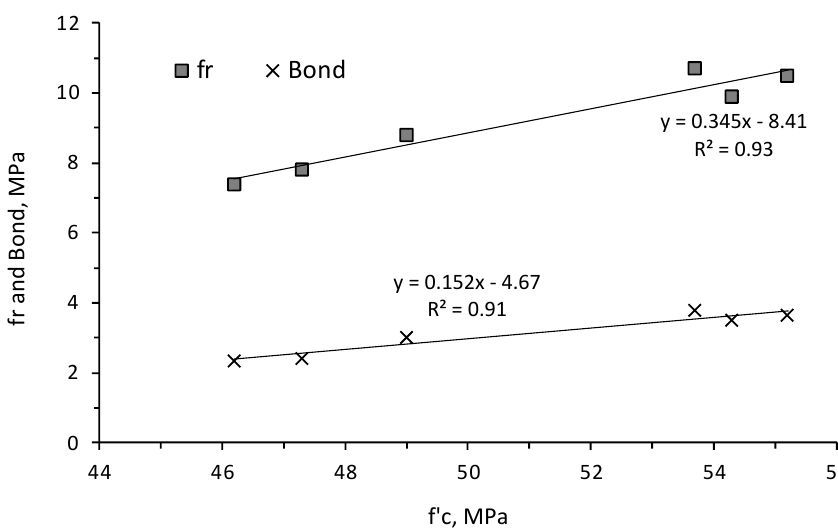
Figure 7. Relationships between f’c vs. fr and pull-off bond properties.